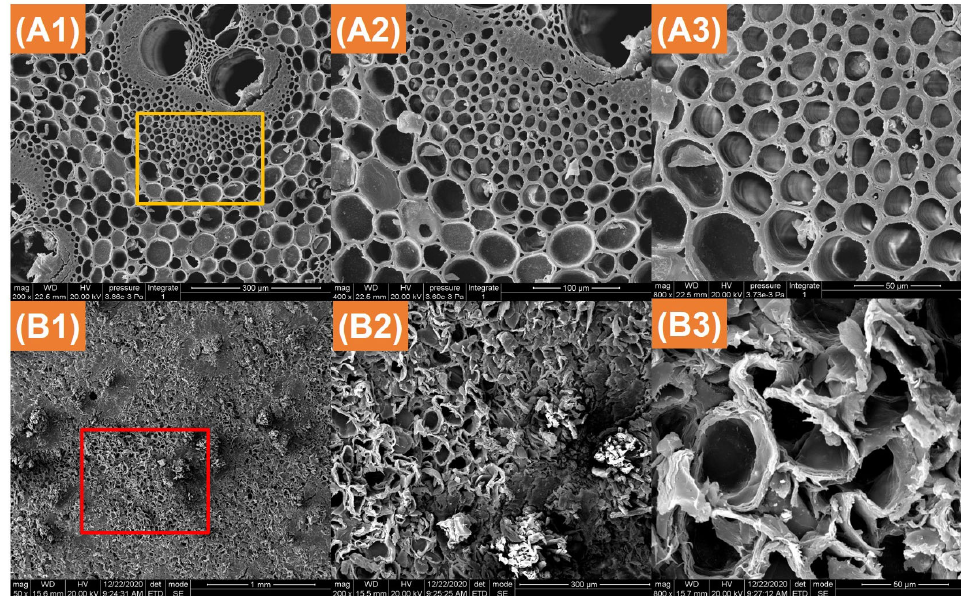
Figure 1. ( A1–A3 ) Images of untreated bamboo in the cross ‐ section and ( B1–B3 ) thermal modified Figure 1. ( A1 – A3 ) Images of untreated bamboo in the cross-section and ( B1 – B3 ) thermal modified bamboo treated under 180 °C/10 min bamboo treated under 180 ◦ C/10 min.